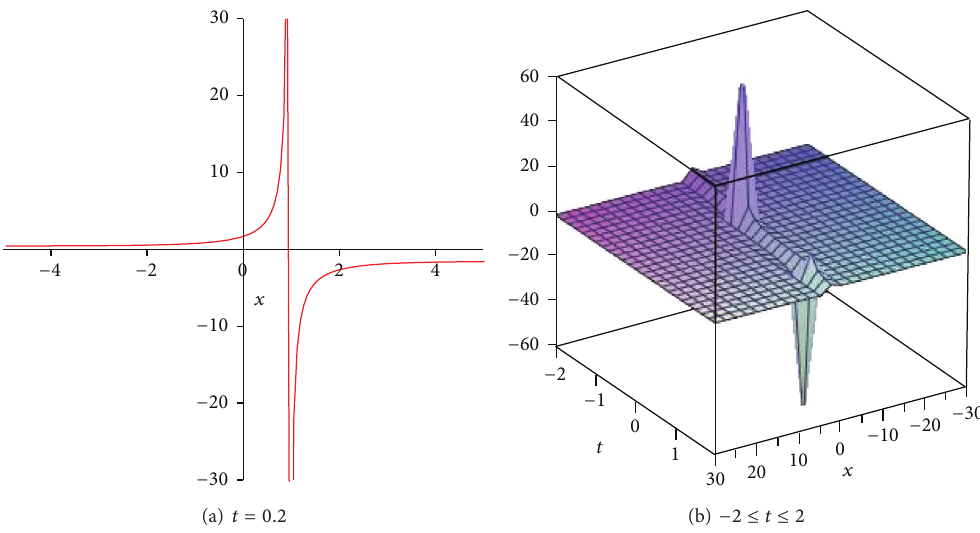
Figure 2: 2D and 3D figures of solution 𝜂 2 (𝜉) in (31) with 𝑎 = 1 , 𝑏 = 1 , 𝐴 1 = 2 , 𝐶 2 = −2 , 𝜉 0 = 0 , 𝜌 3 = 1 , 𝛼 = 1 , and 𝛽 = 1 in the intervals 𝑥 ∈ [−30,30]